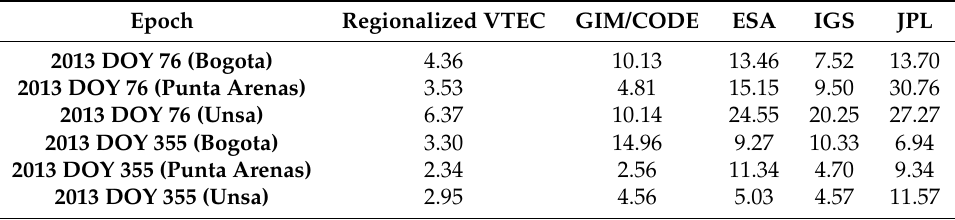
Figure 8. A comparison between the regionalized VTEC estimates of this study, as well as those of GIM/CODE, ESA, IGS and JPL with independent VTEC estimates directly from GPS measurements. Left columns correspond to 17 March 2013 (DOY = 76). Right columns indicate the results on 21 December 2013 (DOY = 355). For comparisons, the regionalized VTEC estimates and those from the CODE, JPL, ESA and IGS products are shown in the plots of the second to fourth rows. Error estimates of the regionalized VTEC model are shown by gray shades around the residual plots. Table 1. Deviation of the regionalized VTEC estimates, as well as those of GIM/CODE, ESA, IGS and JPL from the GPS derived VTEC